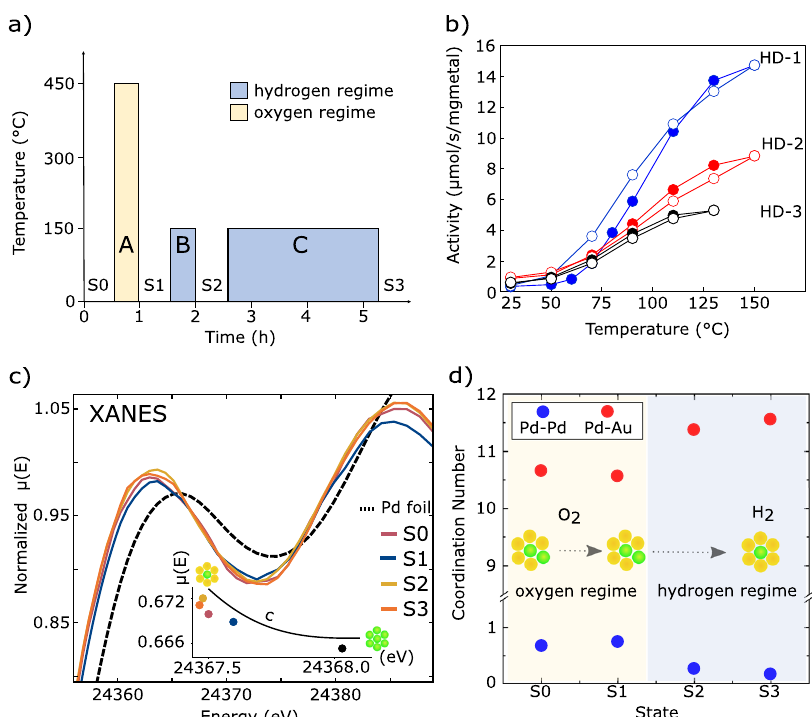
Fig. 2 Pd 8 Au 92 /RCT-SiO 2 is subjected to HD exchange reaction after three sequential pretreatments. a Initial state S0 undergoes O 2 treatment to starting state S1 (treatment A), followed by H 2 treatments to starting states S2 and then S3 (treatments B and C respectively). The hydrogen regime is shaded blue, and the oxygen regime is shaded yellow. b Activity versus temperature for three HD exchange experiments, labeled HD-1 to HD-3, corresponding to three different starting states (S1-S3). The solid and open circles indicate the heating and cooling regimes, respectively. c Normalized XANES collected for the different samples (pink = S0, blue = S1, yellow = S2, orange = S3, and dashed black = Pd foil). The inset shows a shift in the spectral center of mass “ c ” . d Coordination numbers (blue = Pd – Pd bonds and red = Pd – Au bonds) from NN-XANES are consistent with Pd atoms having more Pd neighbors after O 2 treatment (yellow shade) and less Pd neighbors after H 2 treatment (blue shade). Atomic Pd ensembles in ( c ) and ( d ) are depicted with bird ’ s-eye-view schematics (yellow = Au; green =